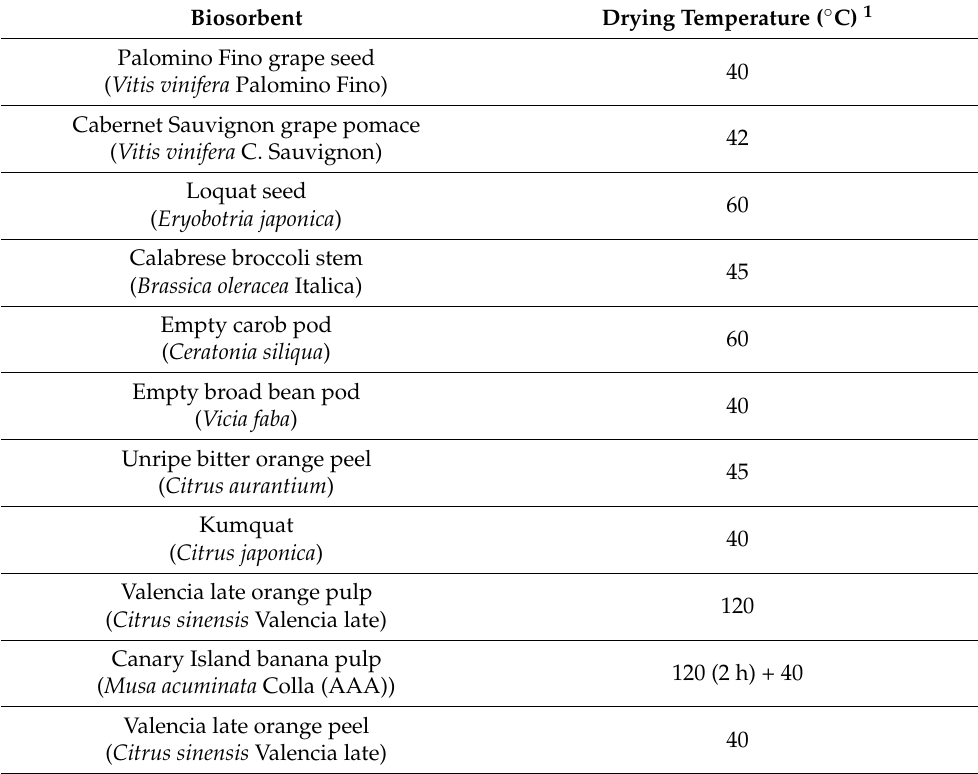
Table 1. Drying temperature values for the different